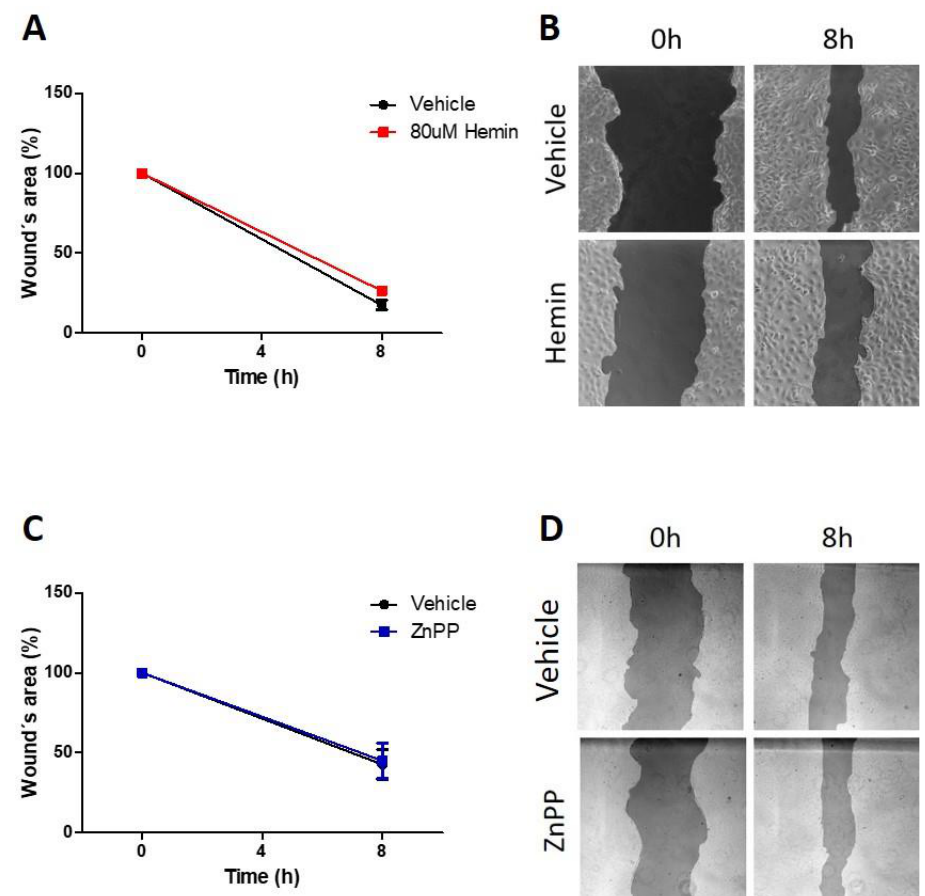
Figure 4. Pharmacological modulation of HO-1 activity does not alter HN13 cell migration. ( A ) HN13 cell migration was evaluated after treatment with 80 uM hemin or its vehicle for 8 h. ( B ) Representative images of an acellular area in 80 uM hemin-treated and vehicle-treated conditions at 0 and 8 h from A are shown. ( C ) HN13 cell migration was evaluated after treatment with 10 uM ZnPP or its vehicle for 8 h. ( D ) Representative images of an acellular area in 10 uM ZnPP treated and control conditions at 0 and 8 h from C are shown.